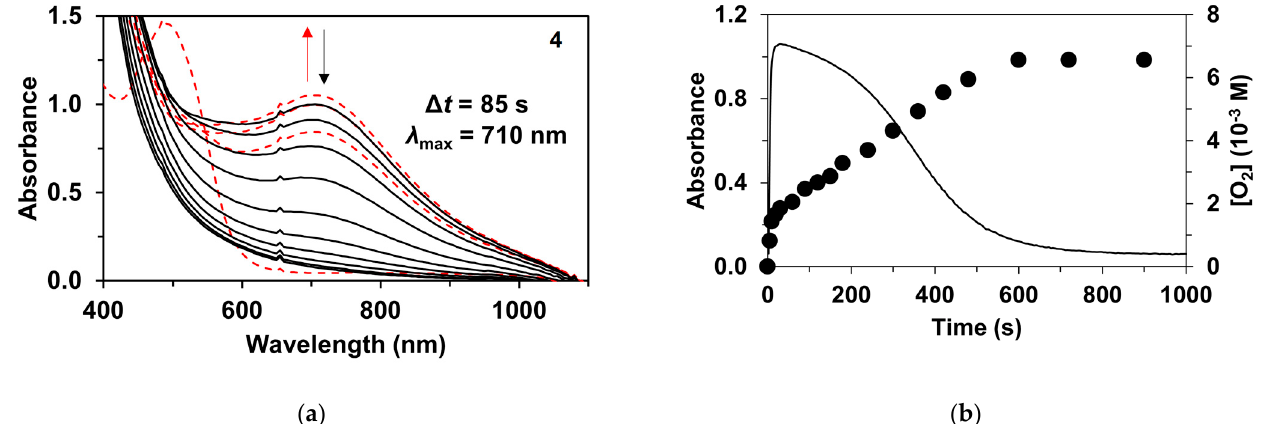
Figure 11. ( a ) UV–Vis spectral changes of 4 P during the catalytic disproportionation reaction of H 2 O 2 . ( b ) Time course of the formation and decay of 4 P during the catalytic disproportionation reaction of H 2 O 2 and the parallel formation of dioxygen monitored by UV–Vis spectroscopy at 710 nm and by volumetrically determined amounts of evolved dioxygen. [ 4 ] 0 = 1.0 × 10 − 3 M, [H 2 O 2 ] 0 = 0.3 M, T = 298 K in MeCN.